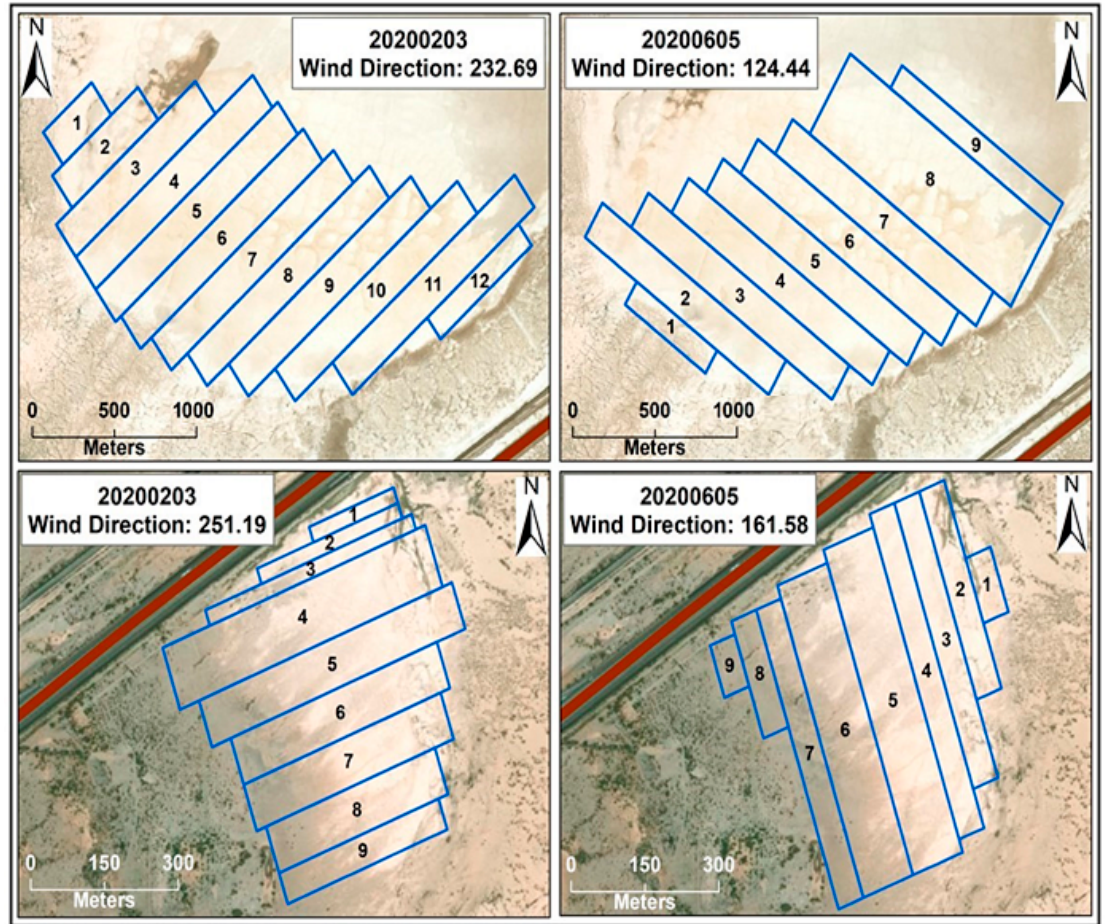
Figure 3. Geometry of field locations at North Playa (top) and Road Forks (bottom) used by the SWEEP and AERMOD models to simulate soil loss, and dust and PM 10 dispersion, respectively,